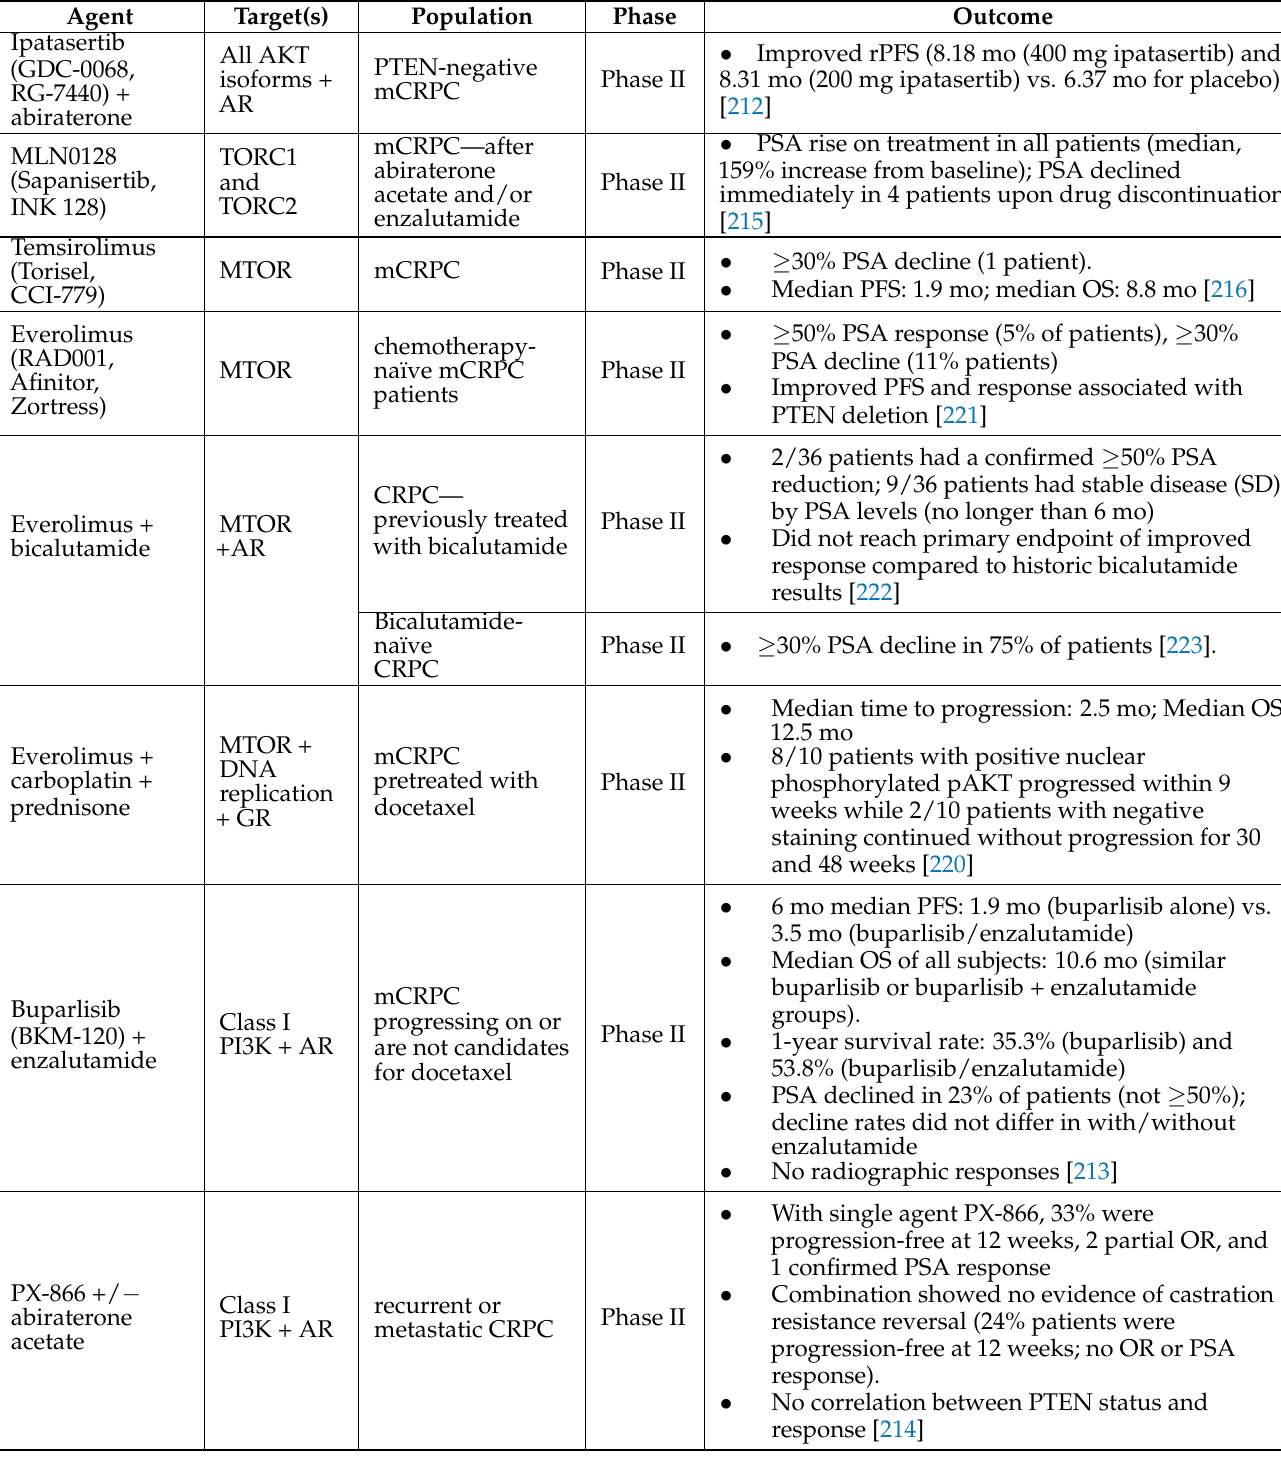
Table 1. Clinical trials of drugs targeting anti-apoptotic signaling in prostate cancer